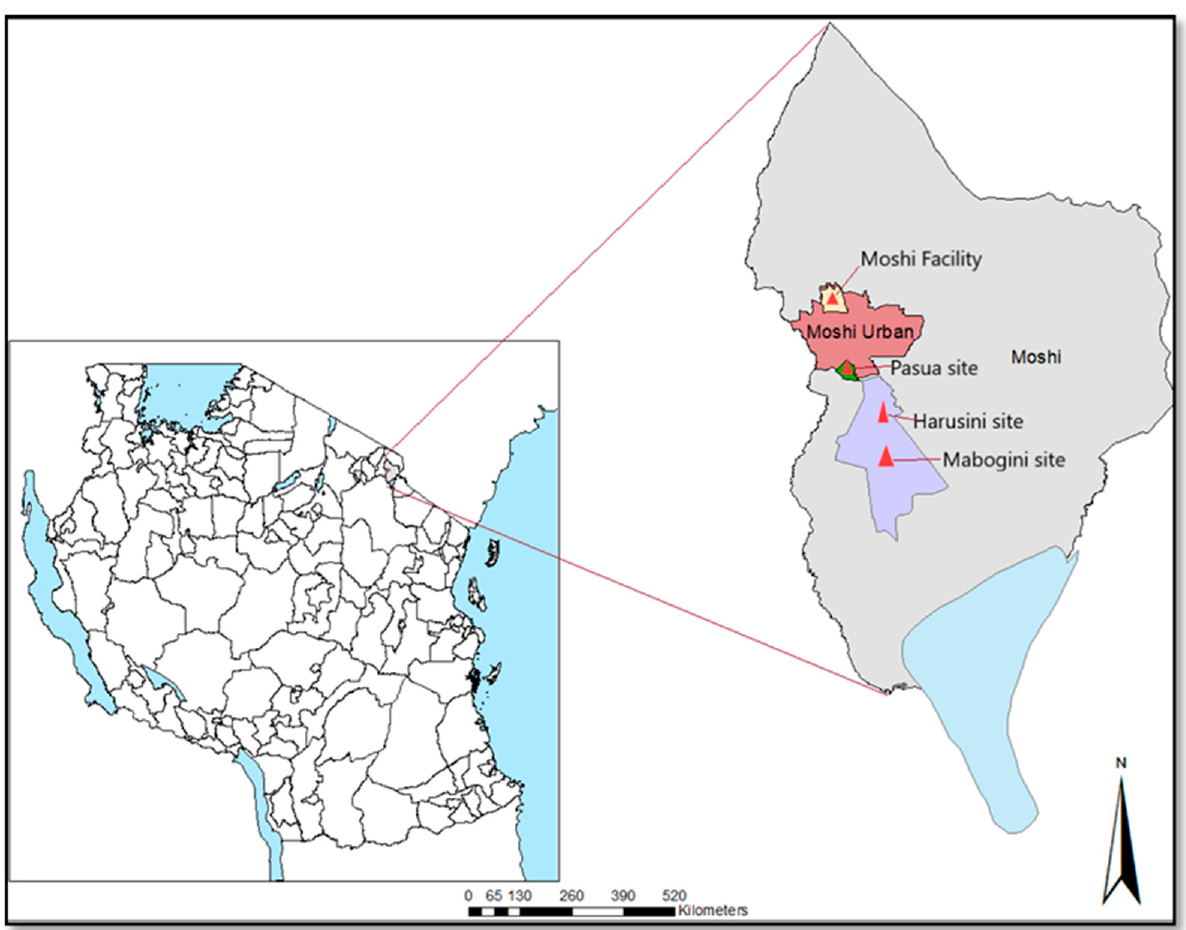
Figure 1. A map of Tanzania indicating the KCMUCo-PAMVERC sites involved with insecticide testing.